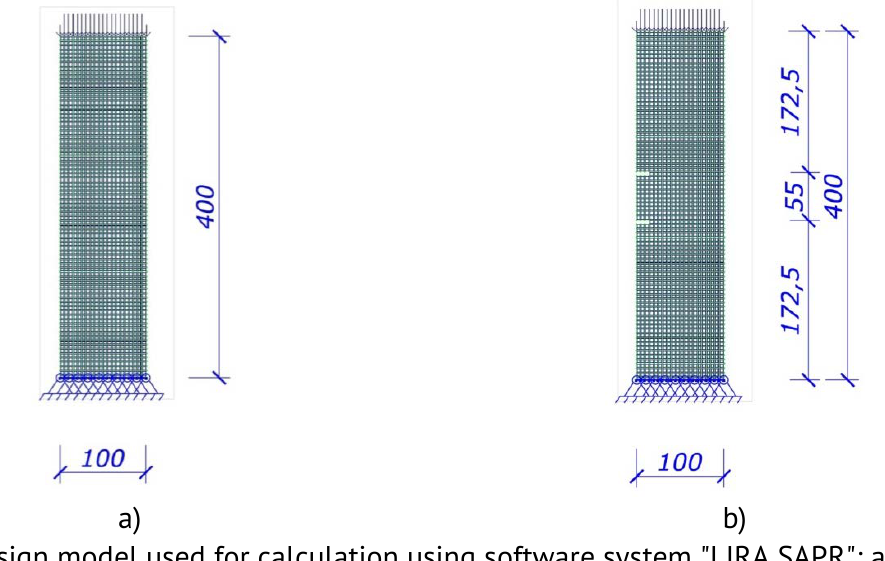
Figure 1. design model used for calculation using software system "LIRA SAPR": a – without structural defects; b – with structural defects.